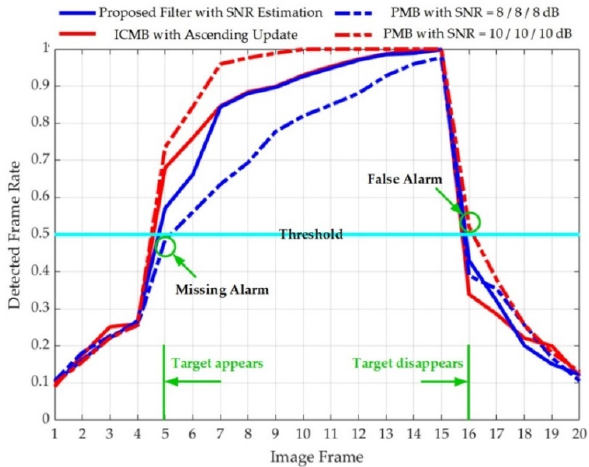
Figure 13. Comparison results of detected frame rate.